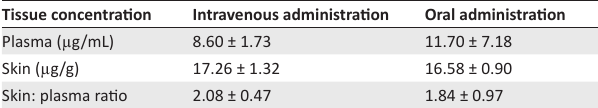
TABLE 2: Lincomycin plasma and skin concentrations (mean ± s.d.) taken two hours after lincomycin administration and skin: plasma concentration ratio after intravenous and oral administration (15 mg/kg) to cats ( n =